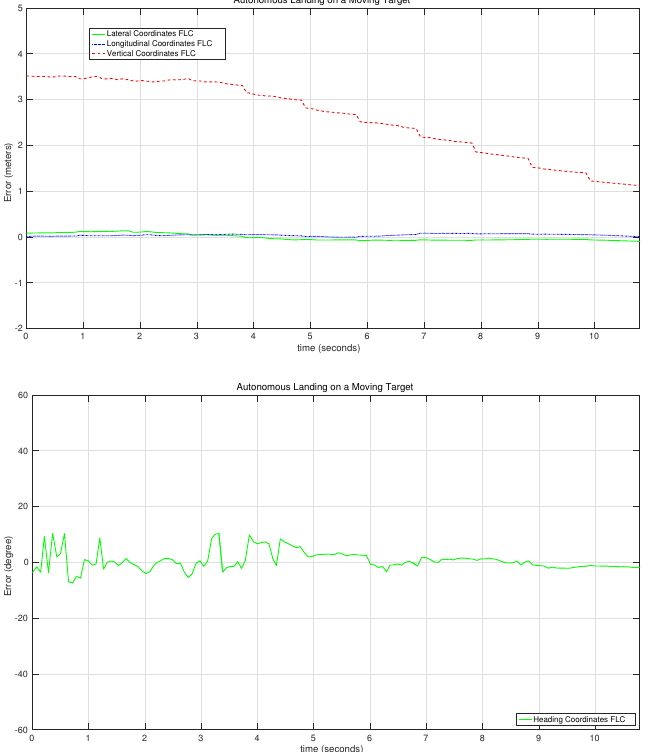
Figure 20. Evolution of the error of the lateral, longitudinal, vertical and heading controllers on the second autonomous landing on a moving target